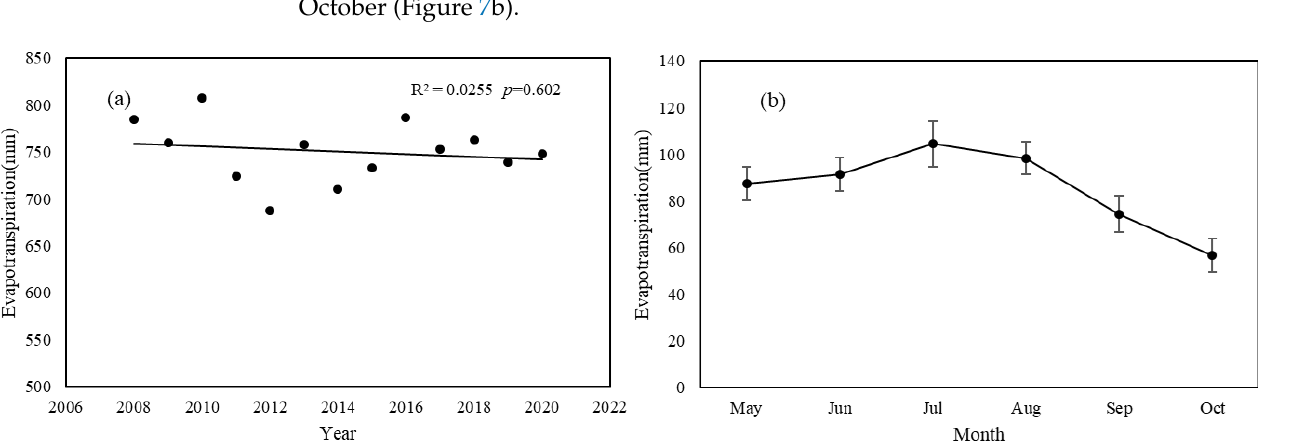
Figure 6. Inter- and intra-annual variation of evapotranspiration. ( a ) Indicates interannual variation of evapotranspiration, and ( b ) indicates months’ variation of soil water deficit.